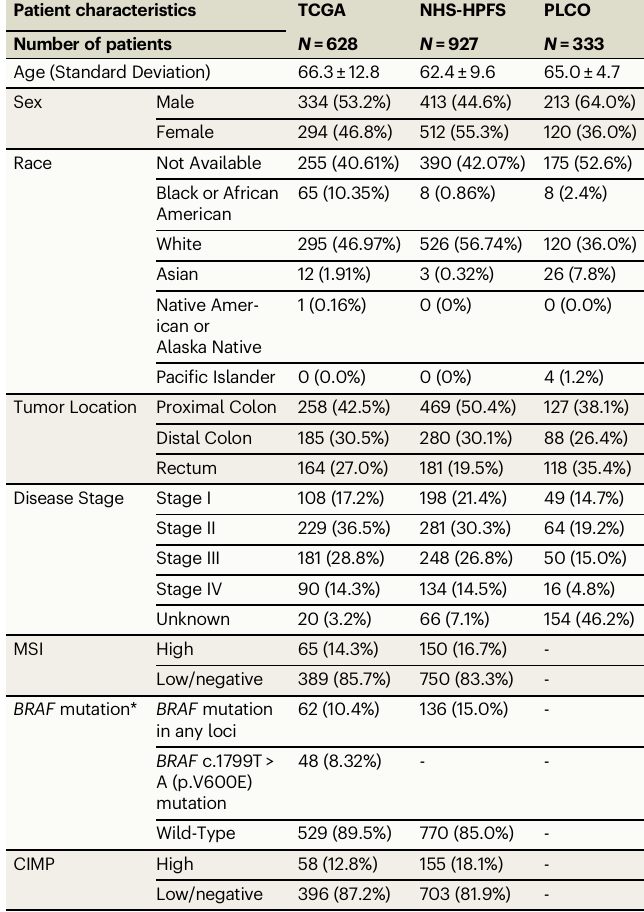
Table 1 | Patient characteristics of our study cohorts Patient